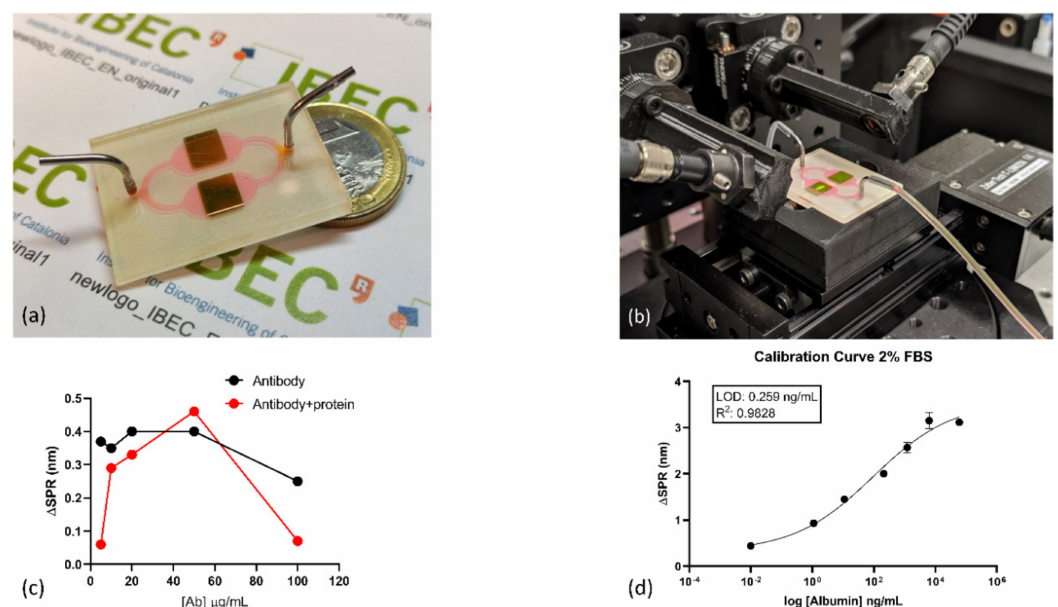
Figure 4. Experimental setup and optimization of biosensing assay. ( a ) Photograph of the 2-channel packed sensor. ( b ) Photograph of the experimental system. ( c ) Mouse serum albumin (capture antibody) optimization. The black line corresponds to SPR shift obtained by changing the MSA concentration on the functionalized nanoplasmonic surface; Redline corresponds to SPR shift obtained after evaluating detection of 1 µ g / mL albumin at the previous MSA concentrations anchored on sensors surface ( d ) calibration curve of albumin detection performed in DMEM cell media containing 2%FBS. LOD of 0.26 ng / mL was